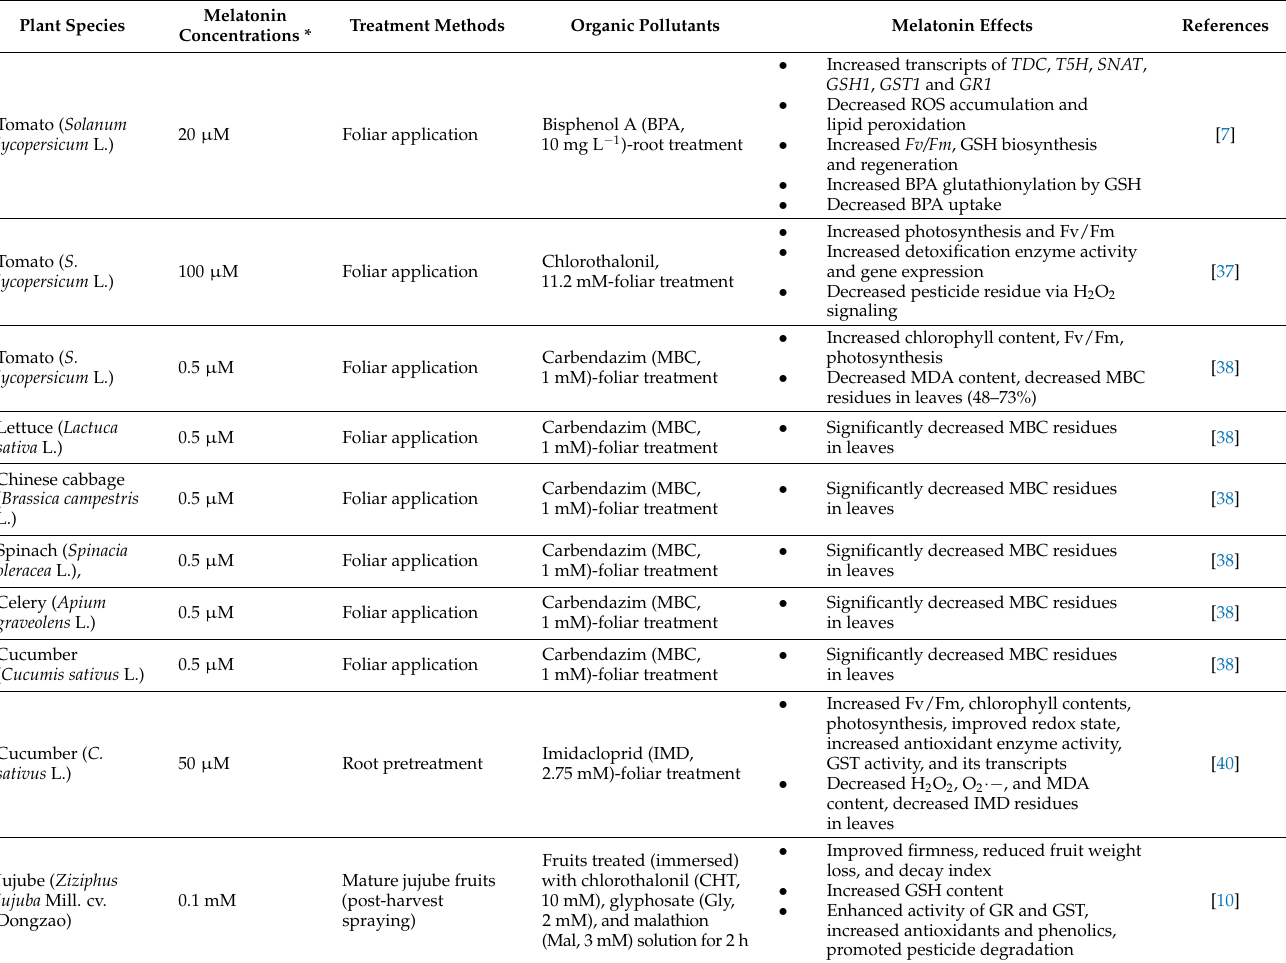
Table 1. Effects of exogenous melatonin on xenobiotic detoxification and alleviation of